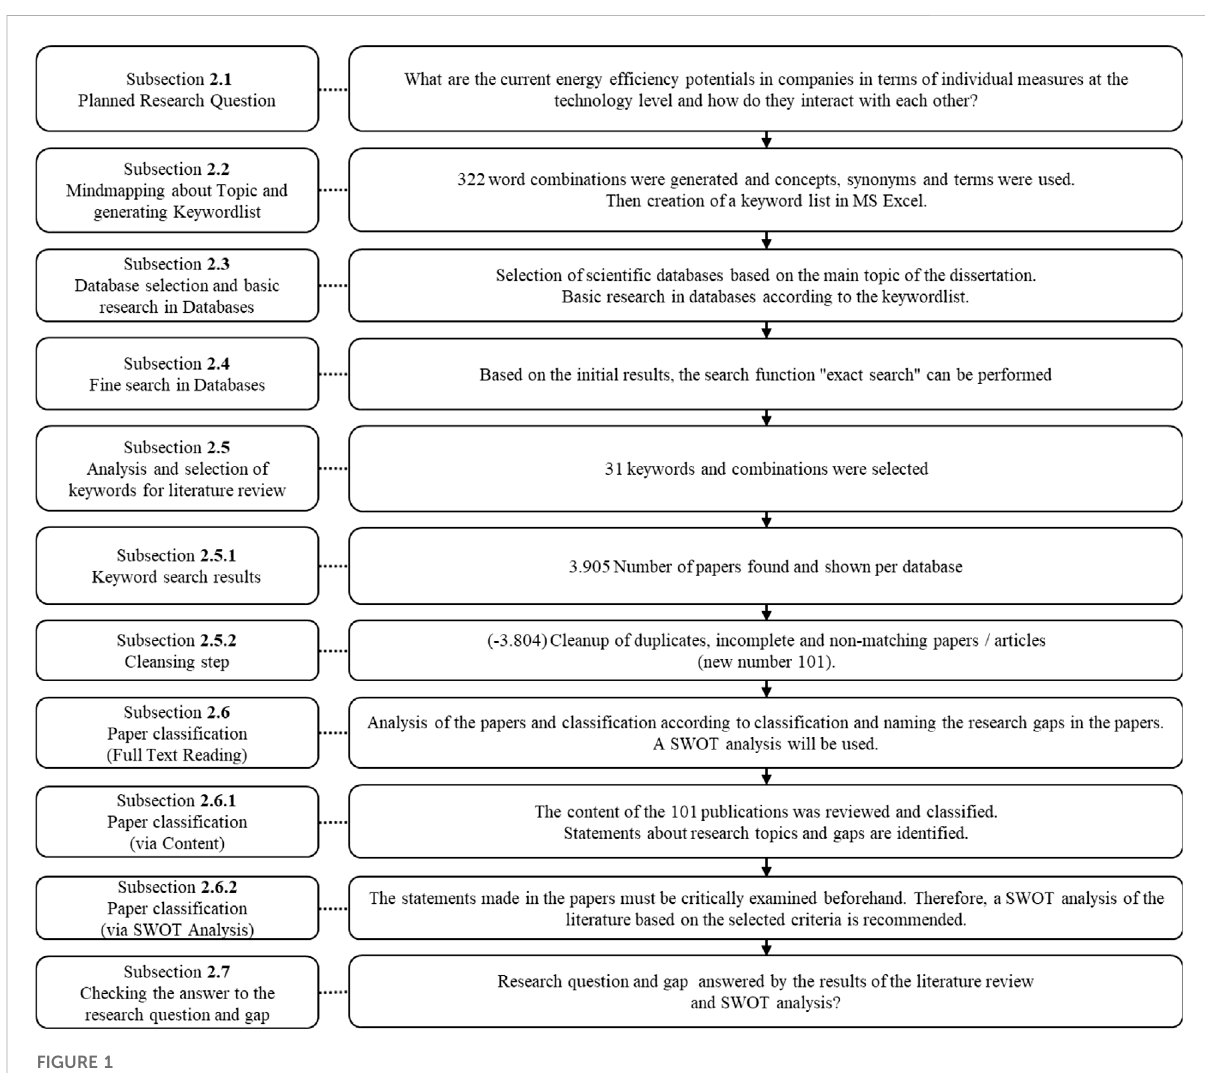
FIGURE 1 Procedure literature